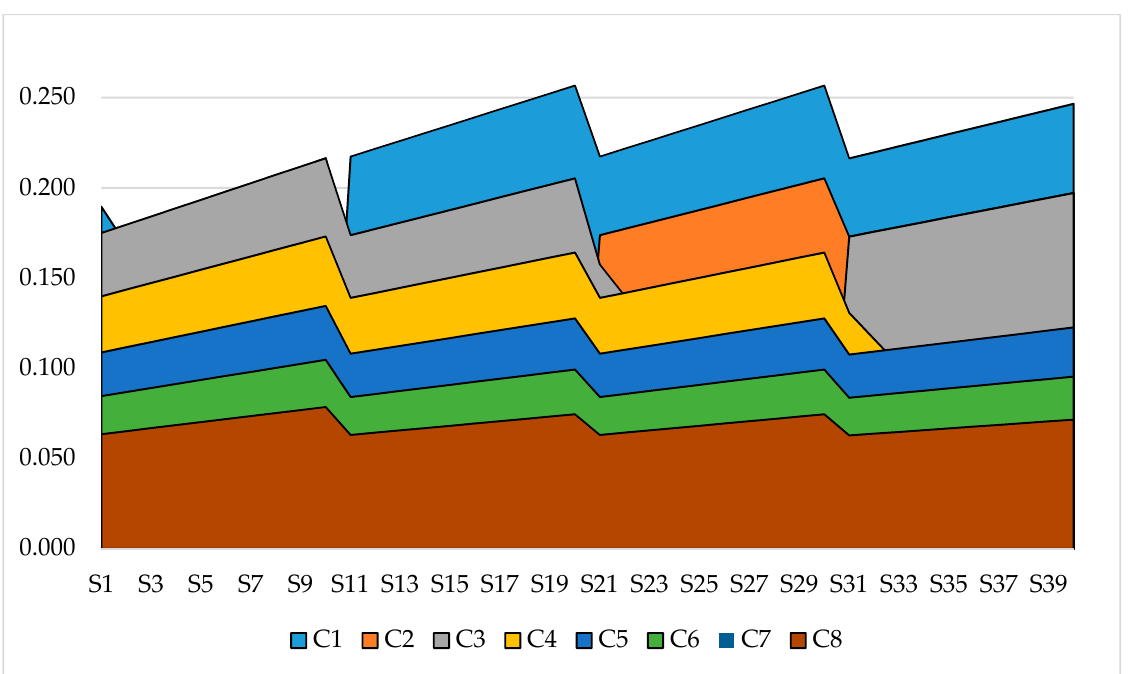
Figure 5. Input weight coefficient values through 40 scenarios.